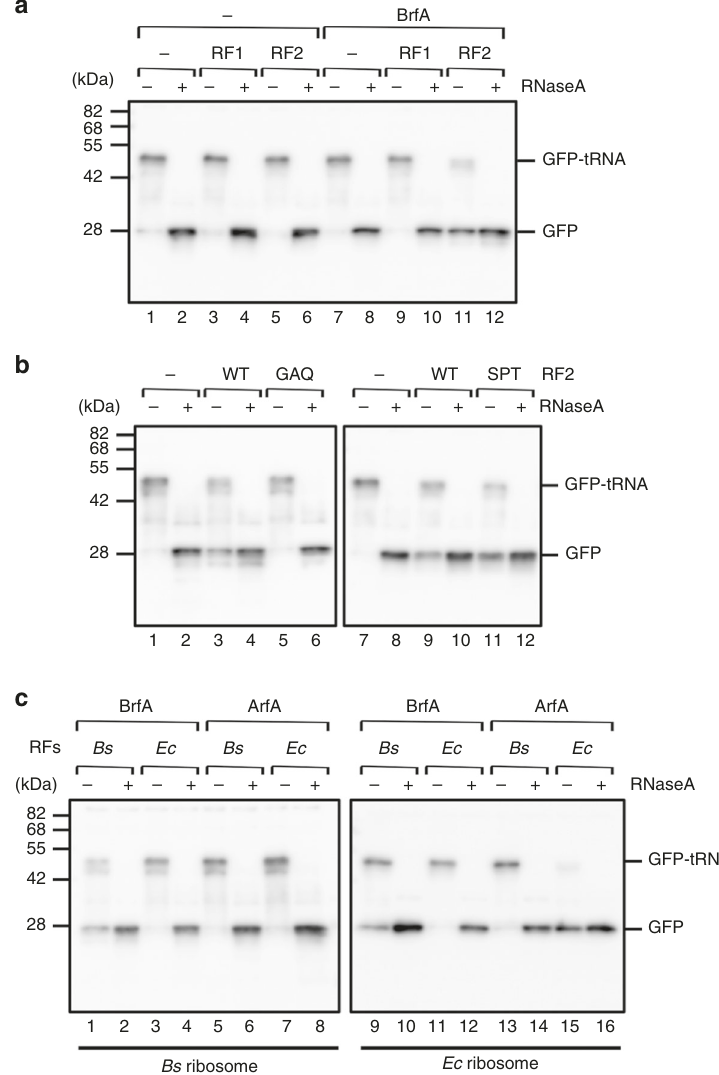
Fig. 3 In vitro activity of BrfA to hydrolyze non-stop peptidyl-tRNA. a BrfA in combination with RF2 cleaves the GFP-tRNA non-stop translation product. In vitro translation using Bs hybrid PURE system was directed by the gfp-ns template. The reaction mixtures contained puri fi ed BrfA62-His 6 (lanes 7 – 12), puri fi ed B. subtilis RF1 (lanes 3, 4, 9, and 10), and RF2 (lanes 5, 6, 11, and 12), as indicated. Translation was allowed to proceed at 37 °C for 20 min, and the products were divided into two parts, one of which was treated with RNase A, as indicated. Samples were then analyzed by SDS-PAGE under neutral pH conditions, followed by anti-GFP immunoblotting. b BrfA-dependent peptidyl-tRNA hydrolysis activity of RF2 requires its GGQ active site but not SPF stop codon recognition motif. In vitro translation using Bs hybrid PURE system was directed by the gfp-ns template in the presence of combinations of BrfA, wild- type RF2 (lanes 3, 4, 9, and 10), RF2(GAQ) (lanes 5 and 6), and RF(SPT) (lanes 11 and 12), as indicated. The translation products were analyzed by